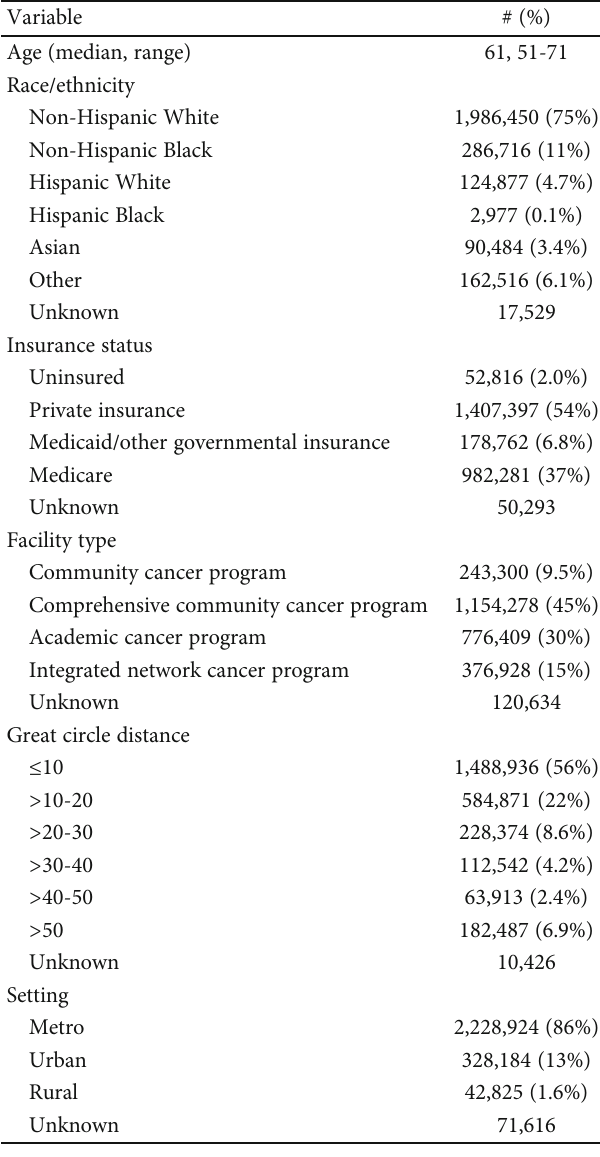
Table 1: Sociodemographic characteristics of breast cancer patients diagnosed between 2004 and